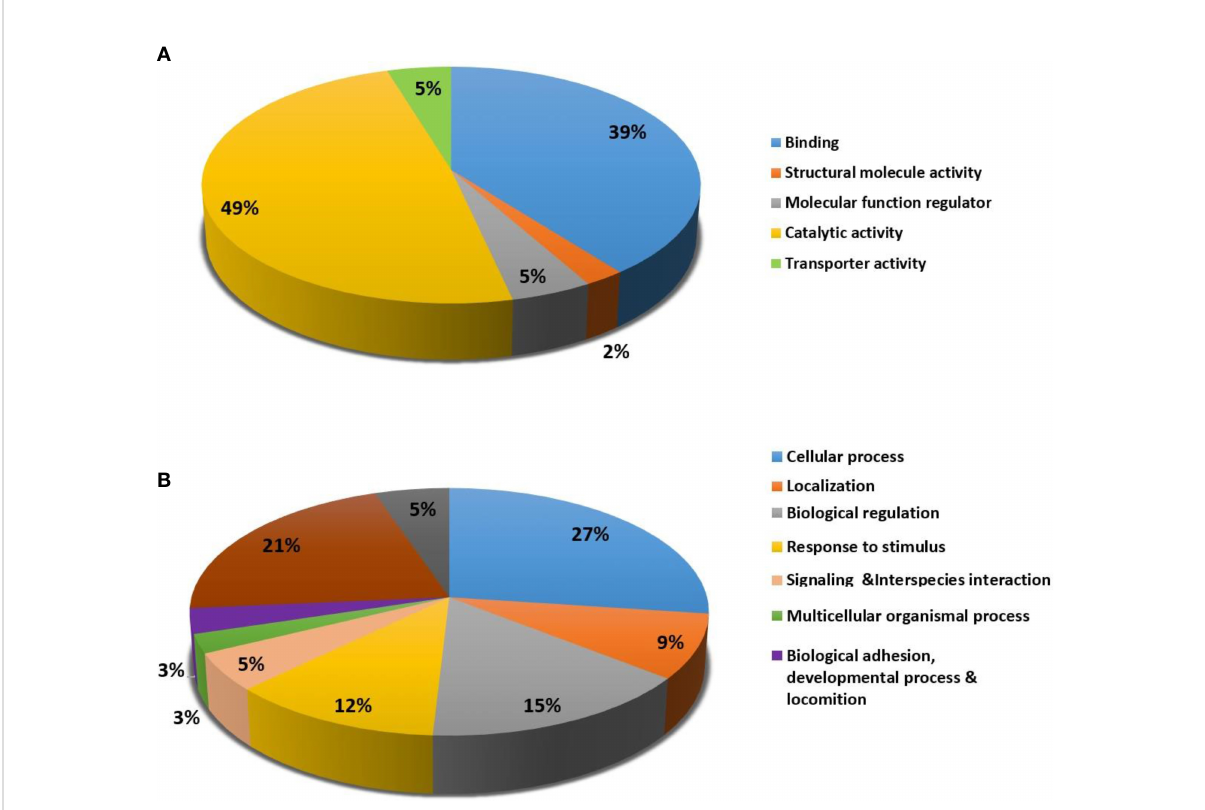
FIGURE 5 Comparative representation (percentage) of identi fi ed proteins divided into groups based on their Molecular function (A) and Biological process (B)